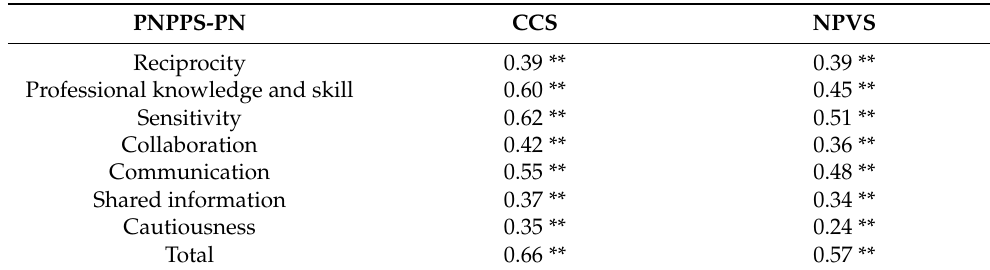
Table 4. Correlation Between the PNPPS-PN, Compassion Competence, and Nursing Professional Value/Reliability of the PNPPS-PN.